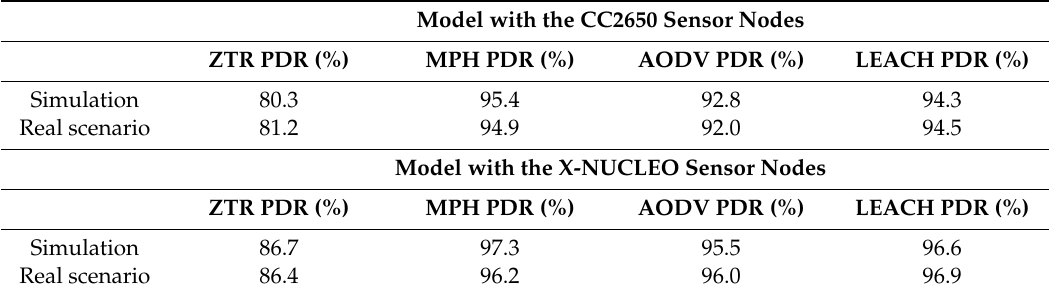
Table 7. E ff ective sent and lost messages: Packet Delivery Ratio (PDR).